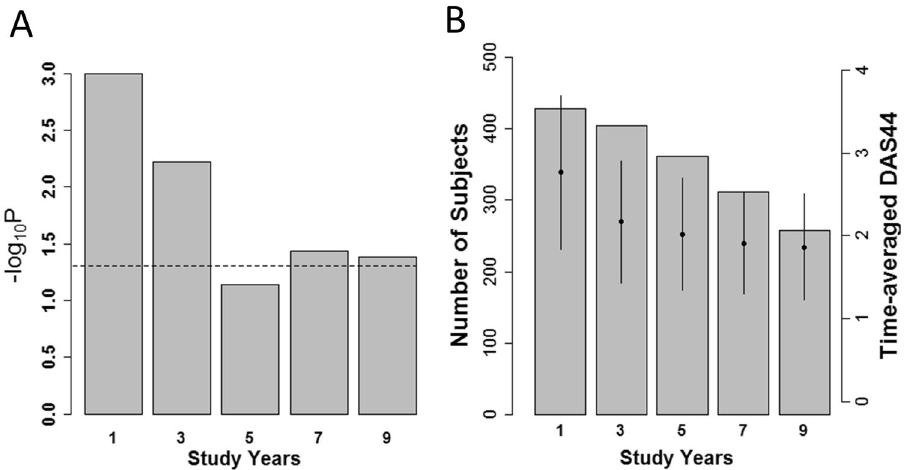
Figure 4. Better fit of time-averaged disease activity on joint destruction than one-time disease activity in the BeSt study. ( A ) Empirical p-values of time-averaged DAS44 from the registry to the study years are indicated. The horizontal line indicates p-value of 0.05. ( B ) Bar charts indicate the number of the subjects in the study years. Dot plots and error bars indicate mean and standard deviation of DAS44 in the study years. IORRA = Institute of Rheumatology, Rheumatoid Arthritis; KURAMA = Kyoto University Rheumatoid Arthritis Management Alliance; na = not applicable; SHS = modified Sharp/van der Heijde score; DAS28 = disease activity score 28; CDAI = Clinical Disease Activity Index; RF = rheumatoid factor, and CCP = anti-cyclic citrullinated peptide antibody. The data were expressed with mean ± standard deviation for